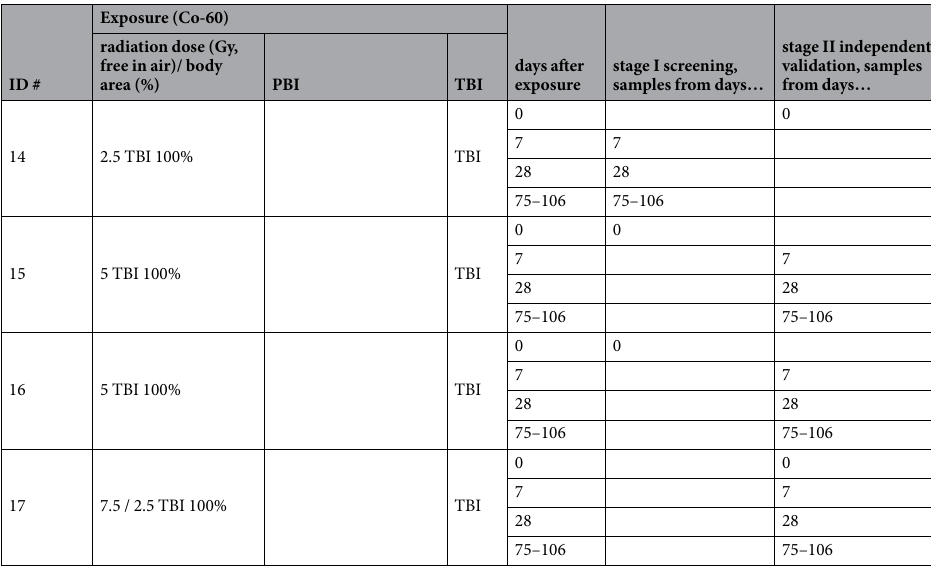
Table 1. The left part of the table describes exposure details of animals irradiated following different partial body irradiation (PBI) exposure pattern or total body irradiation (TBI) exposures with different doses resulting in each animal in either 2.5 Gy or 5 Gy whole body equivalent doses. The right part of the table depicts the assignment of RNA samples to the screening (stage I) or the independent validation (stage II) phase of the